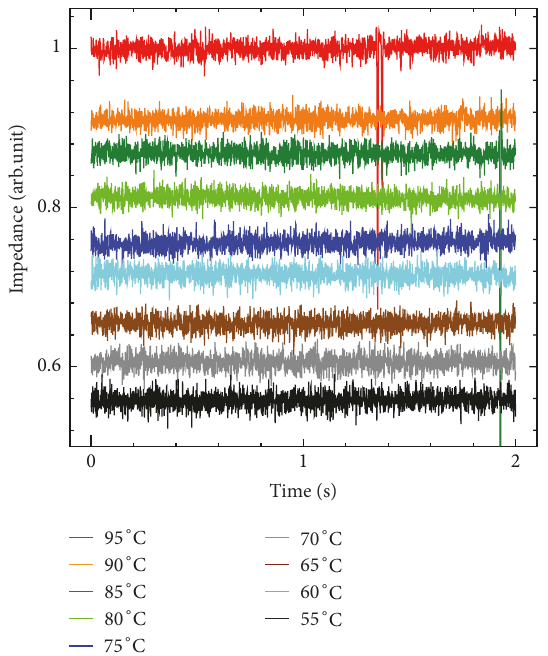
Figure 4: Temperature dependence trend on sensor signals.